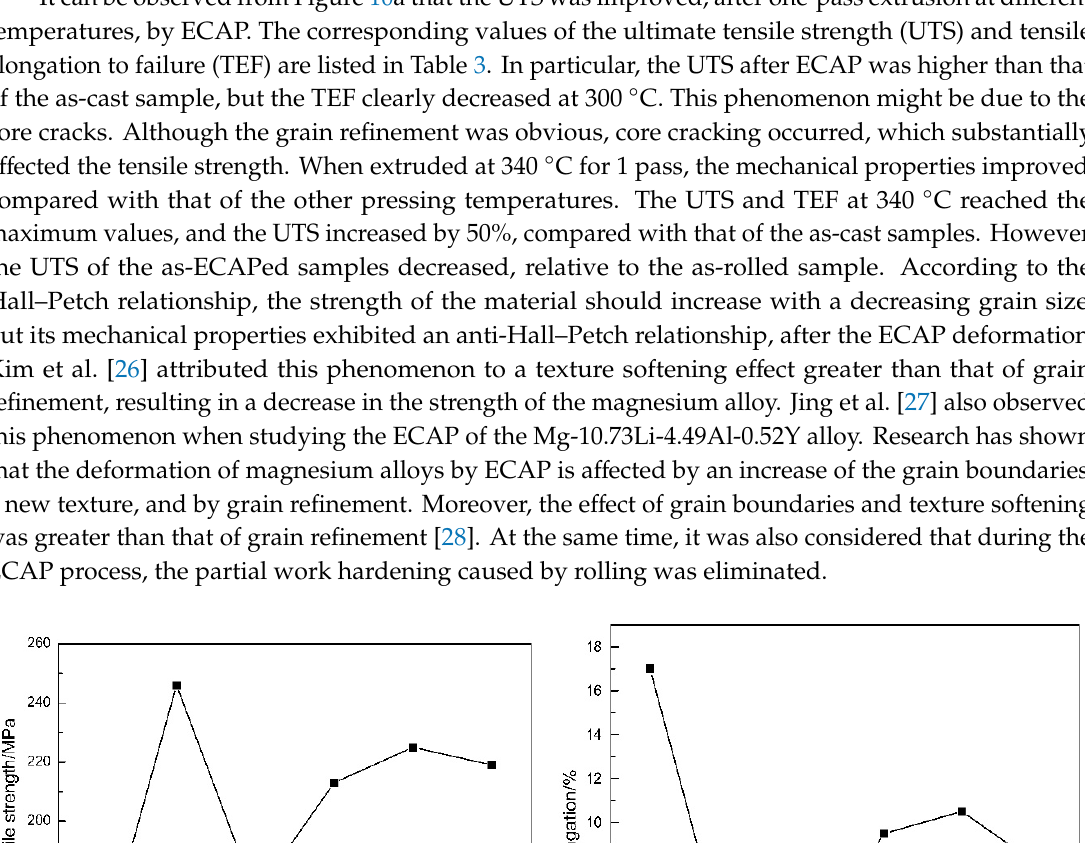
Figure 9. Schmid factor maps of the Mg-2Y-0.6Nd-0.6Zr alloy samples. ( a ) As rolled and ( b ) at 340 °C.